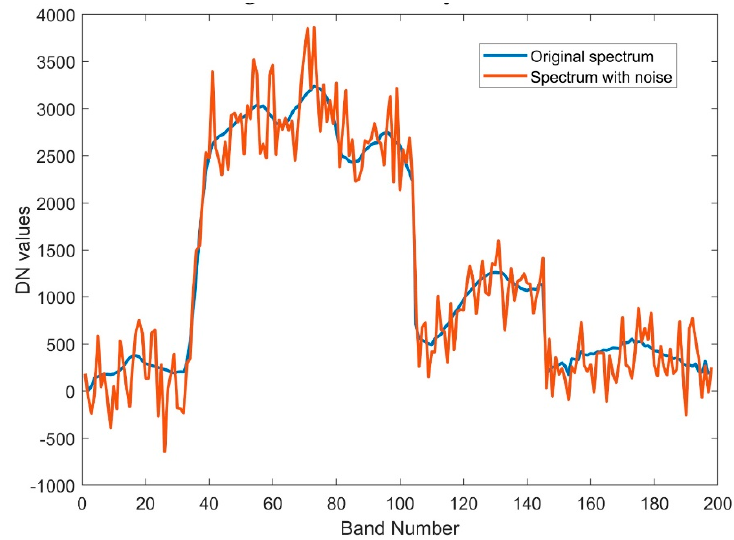
Figure 7. Comparison of spectral curves of the original and noisy data in the Jasper Ridge dataset.